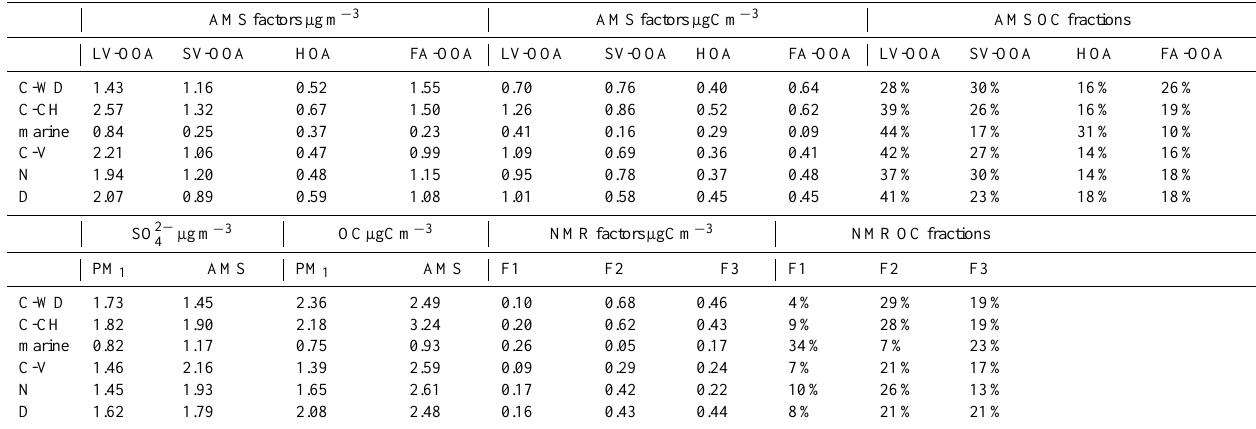
Table 5b. Average concentrations for OC, sulfate, AMS and NMR factors in the four periods of the campaign and for nocturnal (N) and daytime (D)